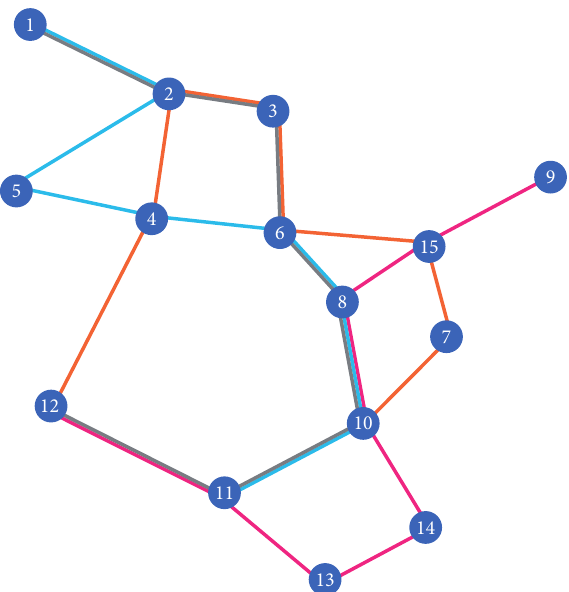
Figure 6: Optimal solution on Mandl’s Swiss network with 4 lines with at most 8 nodes